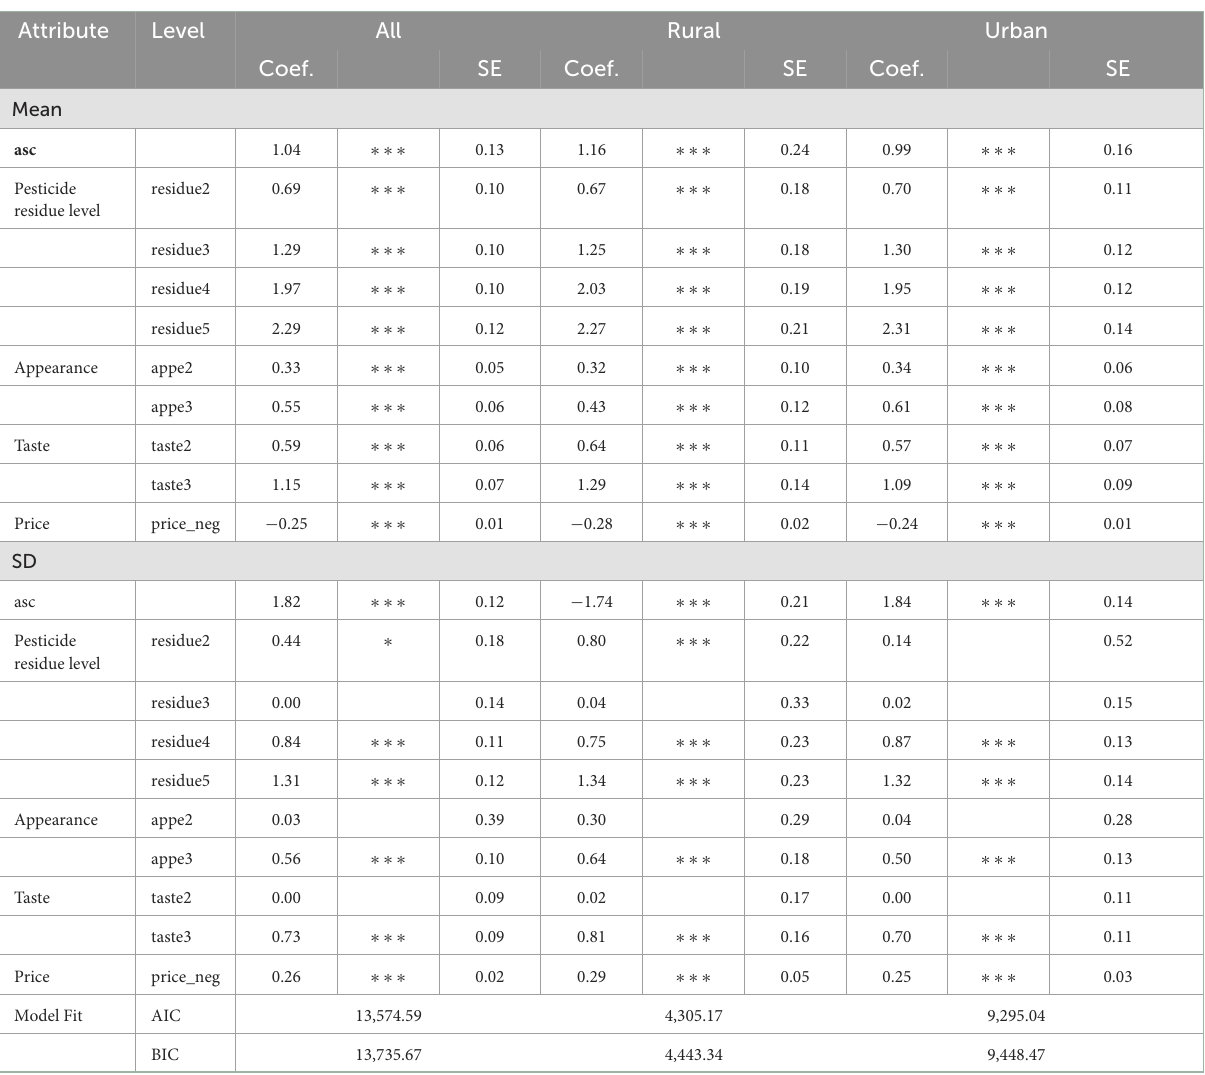
TABLE 5 Mixed logit model estimates result (main effects). Attribute Level All Rural Urban Coef. SE Coef. SE Coef.